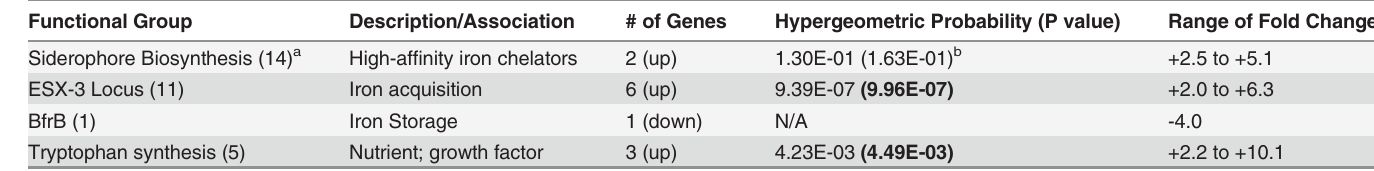
Table 6. Differentially expressed functional categories indicative of M . tb access to iron and nutrients in type II AEC. Functional